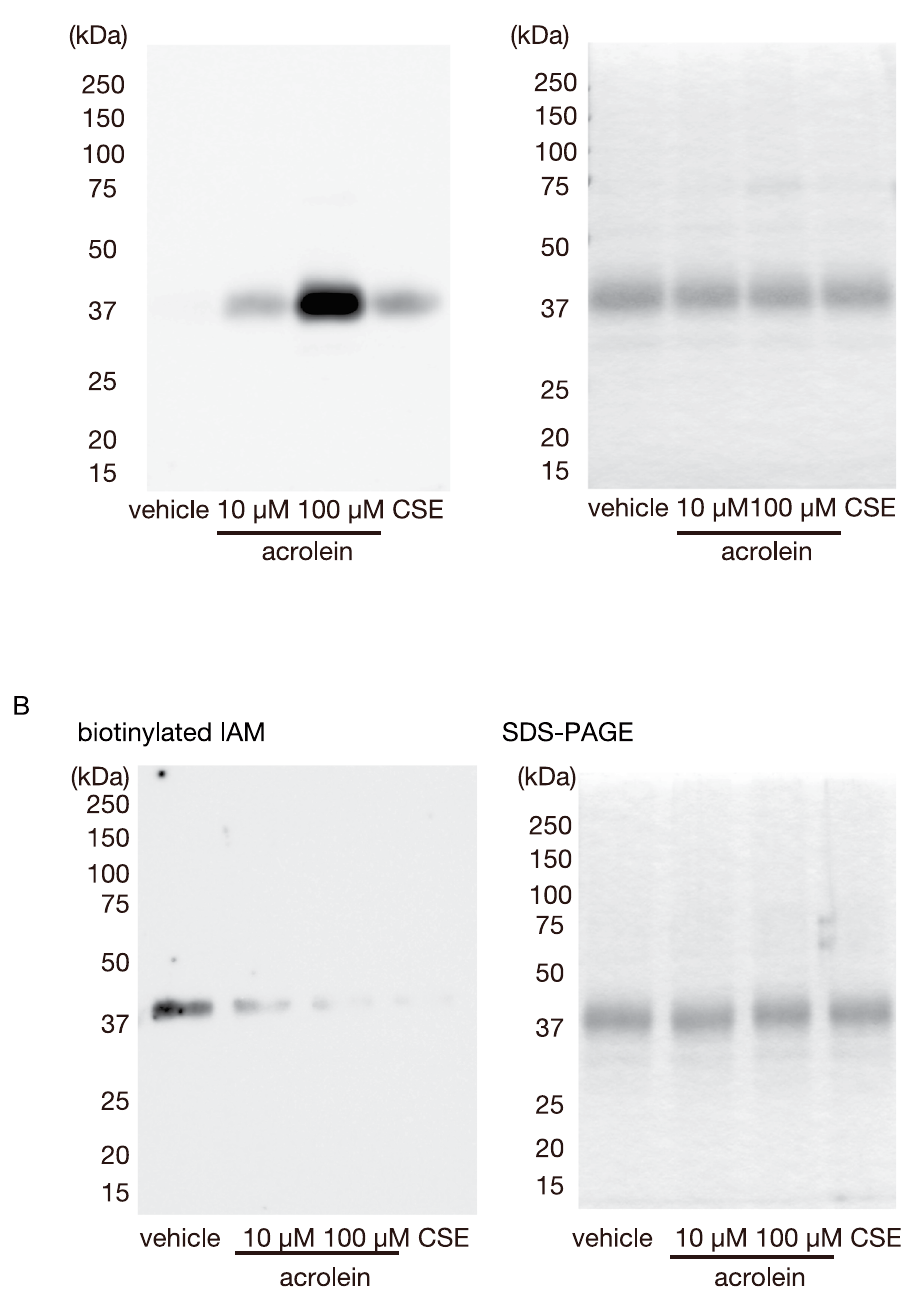
Figure 3. The modification of recombinant hSP-A by acrolein and CSE. Recombinant human SP-A (5 µ M) was incubated with vehicle, acrolein (10 or 100 μ M), or CSE (10%) at 37 °C for 4 h. ( A ) The amount of aldehyde- protein adducts was determined by using ARP. ARP-labeled SP-A was detected by streptavidin blotting (left). A gel stained with Coomassie Brilliant Blue (right). ( B ) The level of the oxidation of thiols in SP-A was determined by using IAM. IAM-labeled SP-A was detected by streptavidin blotting (left). A gel stained with